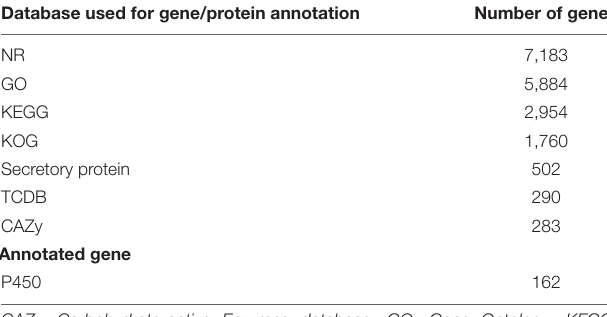
TABLE 1 | General features of the Sarcomyxa edulis genome.